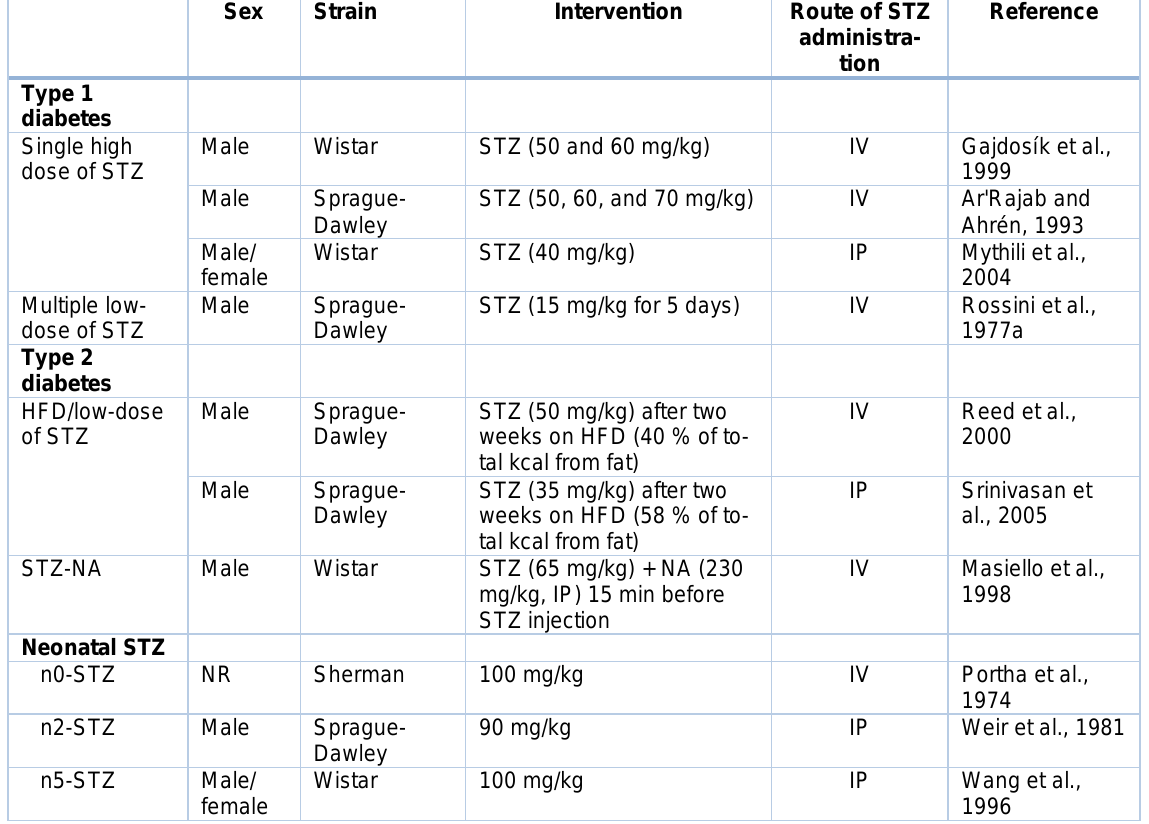
Table 1: Rat models of streptozotocin (STZ)